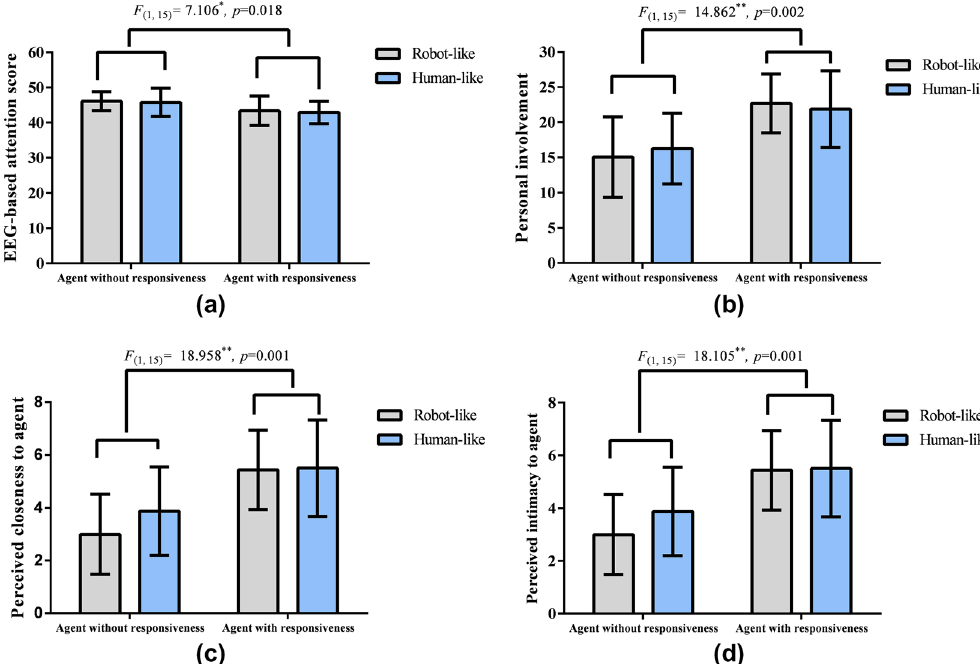
Figure 6. Results on participants’ attention level reported from EEG device ( a ), personal involvement to agent ( b ), perceived closeness ( c ), and intimacy ( d ) in Experiment 1. Participants had a significantly lower level of attention on agents with responsiveness than that without responsiveness ( ∗ p < 0.05 , ∗ ∗ p < 0.01 , confidence intervals (CIs) in figures represent 95 % CIs. However, participants perceived significantly higher level of involvement, closeness, and intimacy in agents with responsiveness than those in agents without